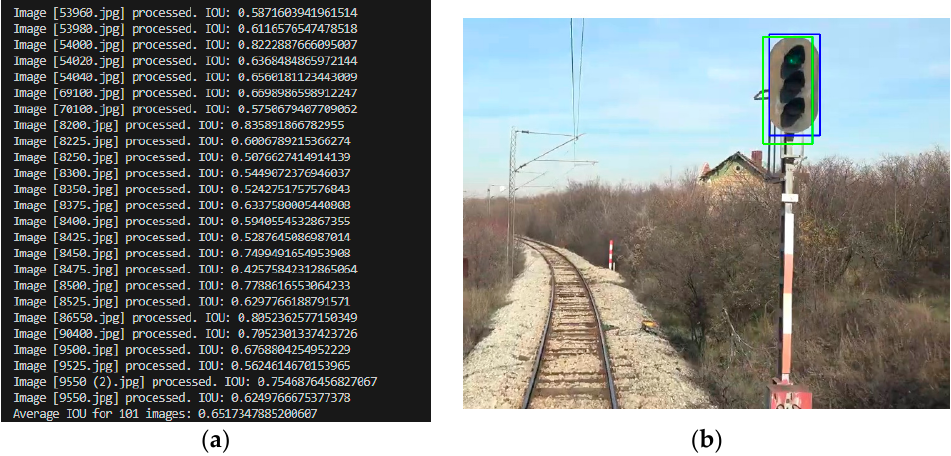
Figure 18. Intersection over union. ( a ) Average IoU of validation dataset. ( b ) Labeled bounding box—blue; predicted bounding box—green.